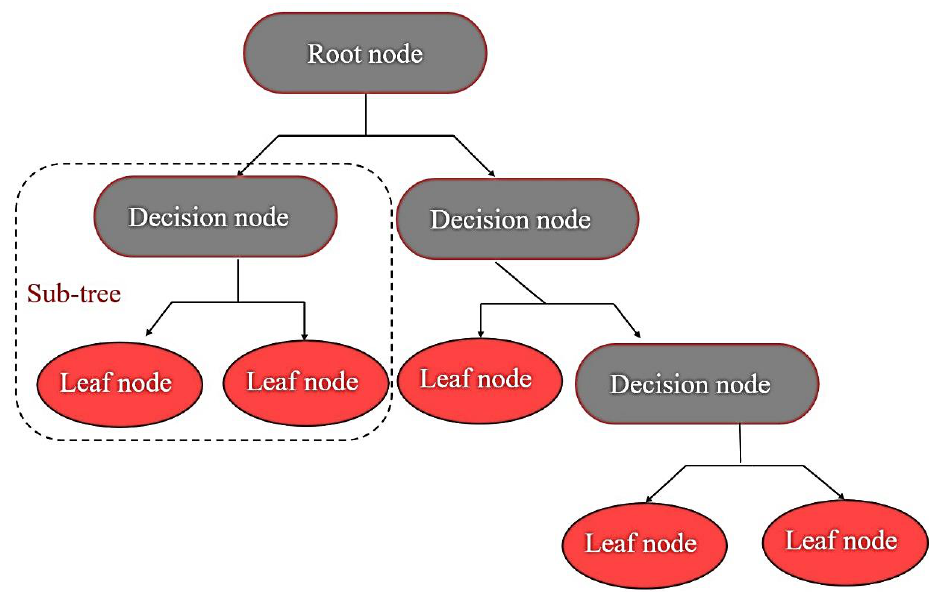
Figure 6. The schematic of decision-making in decision tree. Prediction of new data is made by checking the new data point lies on which